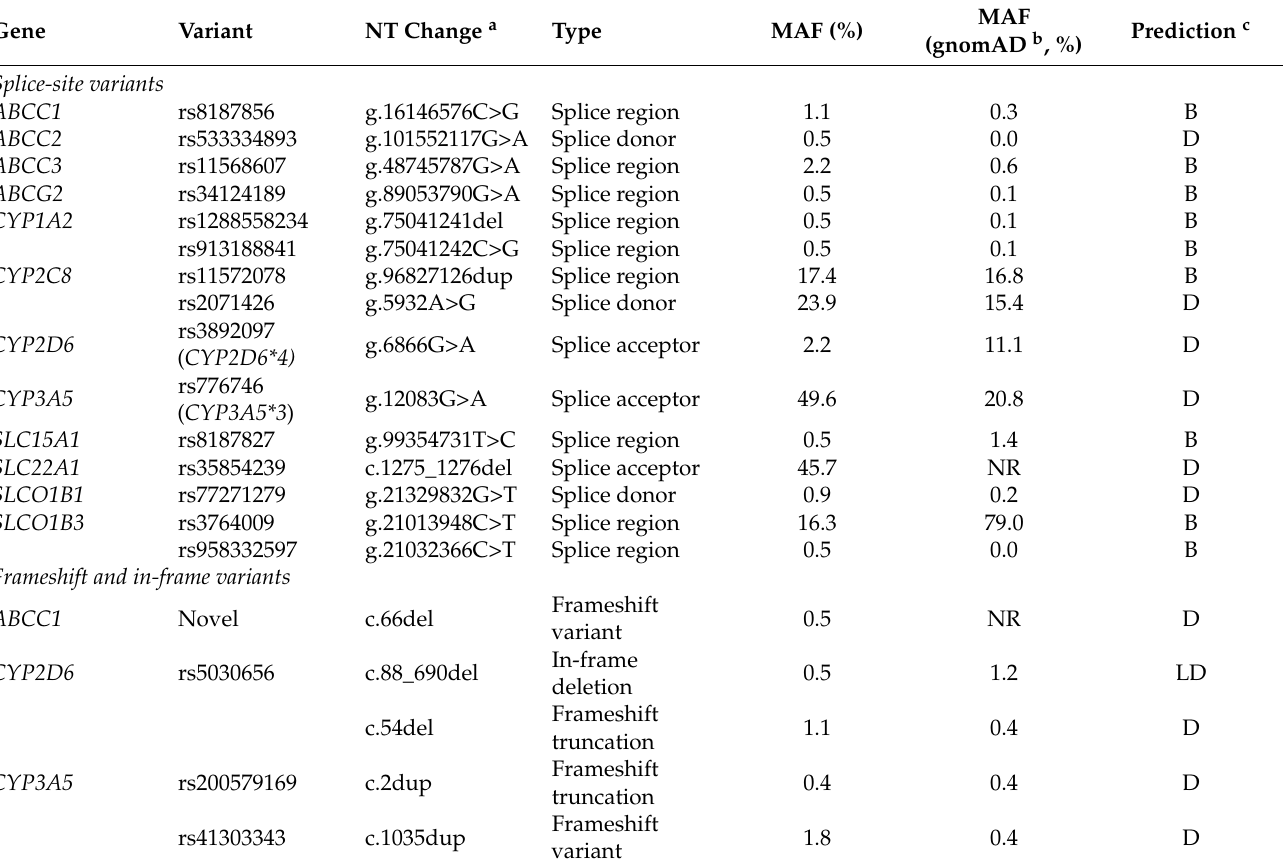
Table 4. In silico functional prediction of splice-site, frameshift, and in-frame variants in PK-related